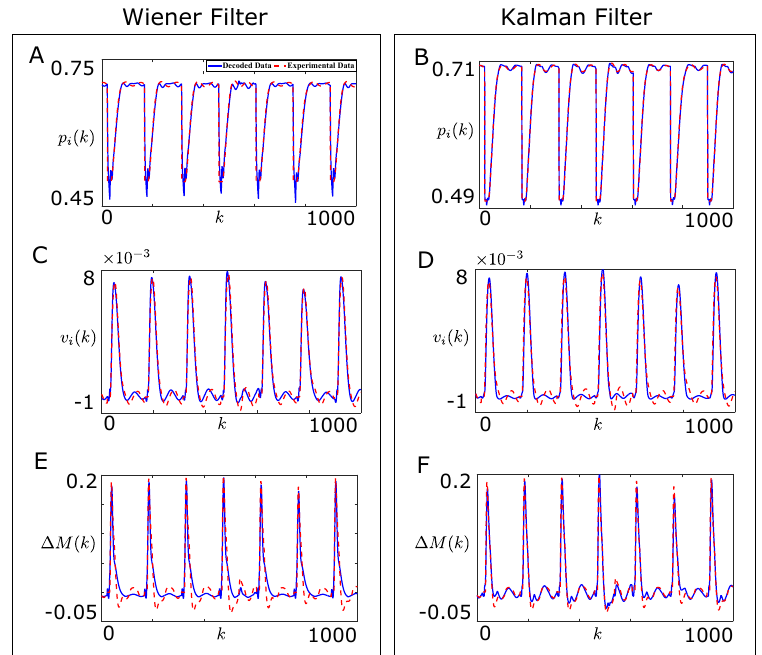
Figure 3. Comparison of the offline performances of the Wiener filter and the Kalman filter based decoders for the single joint reaching task on a sample part of the test data. ( A , C , E ) show the comparison between the experimental (dotted line, red) and the decoded (solid line, blue) joint position p i ( k ) , joint velocity, v i ( k ) and force difference between the agonist and the corresponding antagonist muscle, ∆ M ( k ) respectively for the Wiener filter based decoder; ( B , D , F ) show the comparison between the experimental (dotted line, red) and the decoded (solid line, blue) joint position p i ( k ) , joint velocity, v i ( k ) and force difference between the agonist and the corresponding antagonist muscle, ∆ M ( k ) respectively for the Kalman filter based